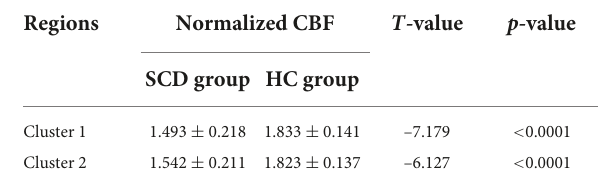
TABLE 3 Results about ROI-based intergroup differences in